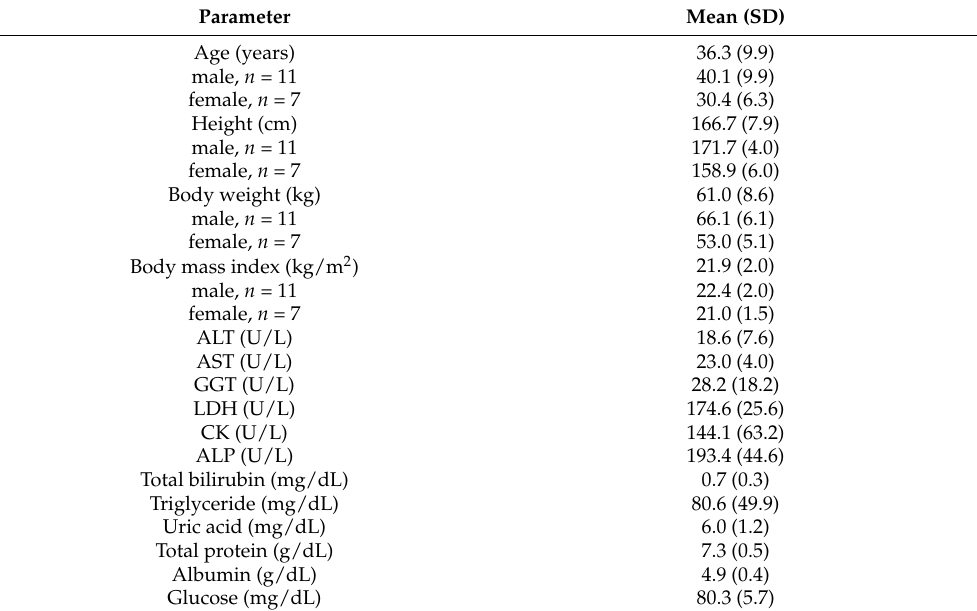
Table 2. Characteristics of the healthy participants ( n = 18).